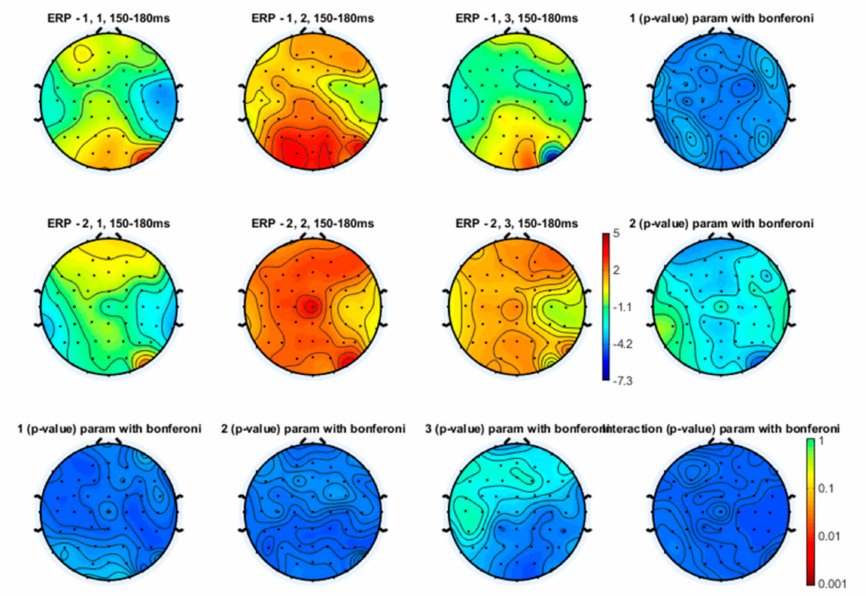
Figure 9. Topographical representation of the N1 component on the left hand stimulation. The first line of topographical maps represents the N1 amplitude in the baseline condition, slow finger tapping (SFT) and fast finger tapping (FFT) in the control group. The second line of maps represents the N1 amplitude in the baseline condition, slow finger tapping (SFT) and fast finger tapping (FFT) in the patient group. The control group’s basal condition (1,1), slow finger tapping (1,2) and fast finger tapping (1,3); the fibromyalgia (FM) group’s basal condition (2,1), slow finger tapping (2,2) and fast finger tapping (2,3) (see also Figure 1). The results of the repeated measures analysis of variance (ANOVA) corrected with the Bonferroni test are